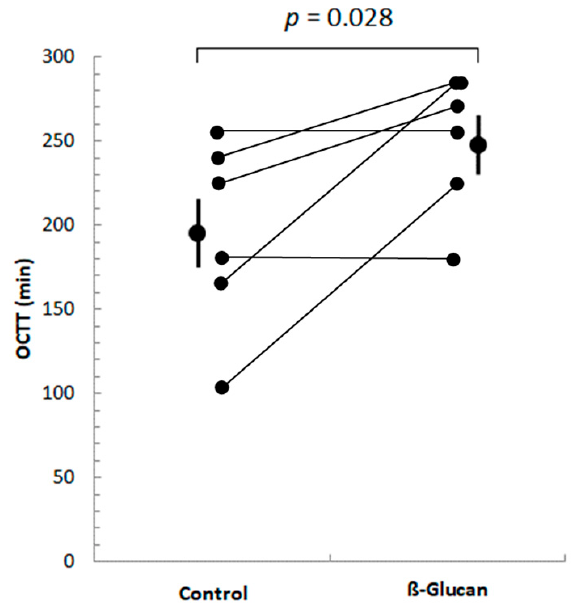
Figure 1. Orocecal transit time (OCTT) of volunteers after ingestion of control or β -glucan breakfast. Only six subjects showed post-prandial increases in their breath H 2 > 20 ppm above baseline H 2 values in both periods. The mean OCTT values (±SEM) of these 6 subjects are shown. OCTT increased significantly ( p = 0.028) in the ß-glucan period compared to the control period. Post-prandial feelings of hunger, fullness, satiety, food craving, and prospective food consumption were evaluated by VAS scoring during the control and β -glucan pe- riods, and the mean appetite score was calculated according to the values obtained. The VAS results are shown in Figure 2; no difference was observed between the two groups for any of the parameters studied.